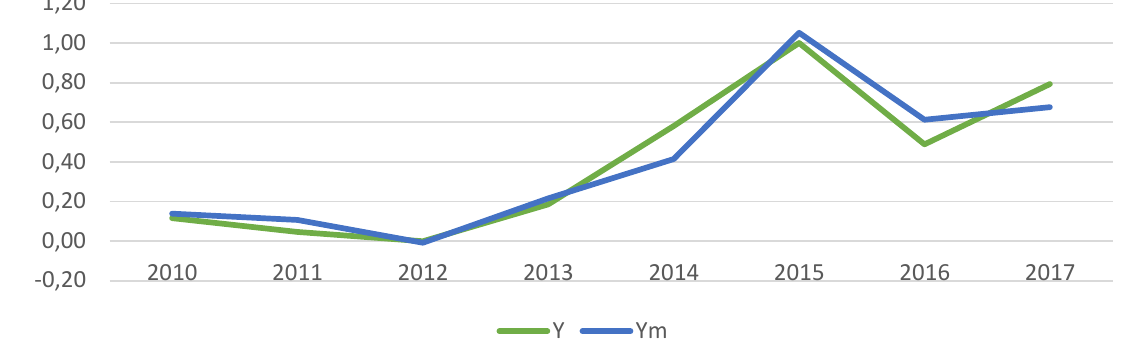
Figure 3. Comparison of actual and simulated model data